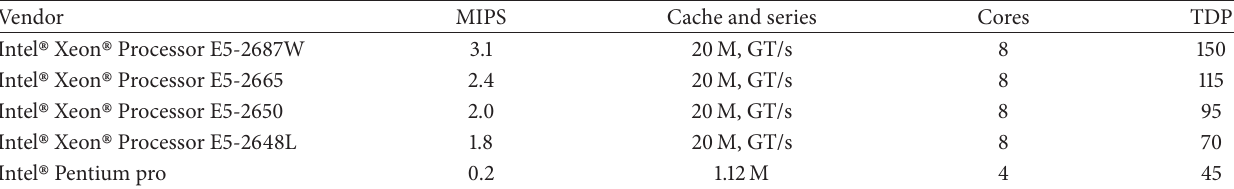
Table 3: Watts consumption of 5-level